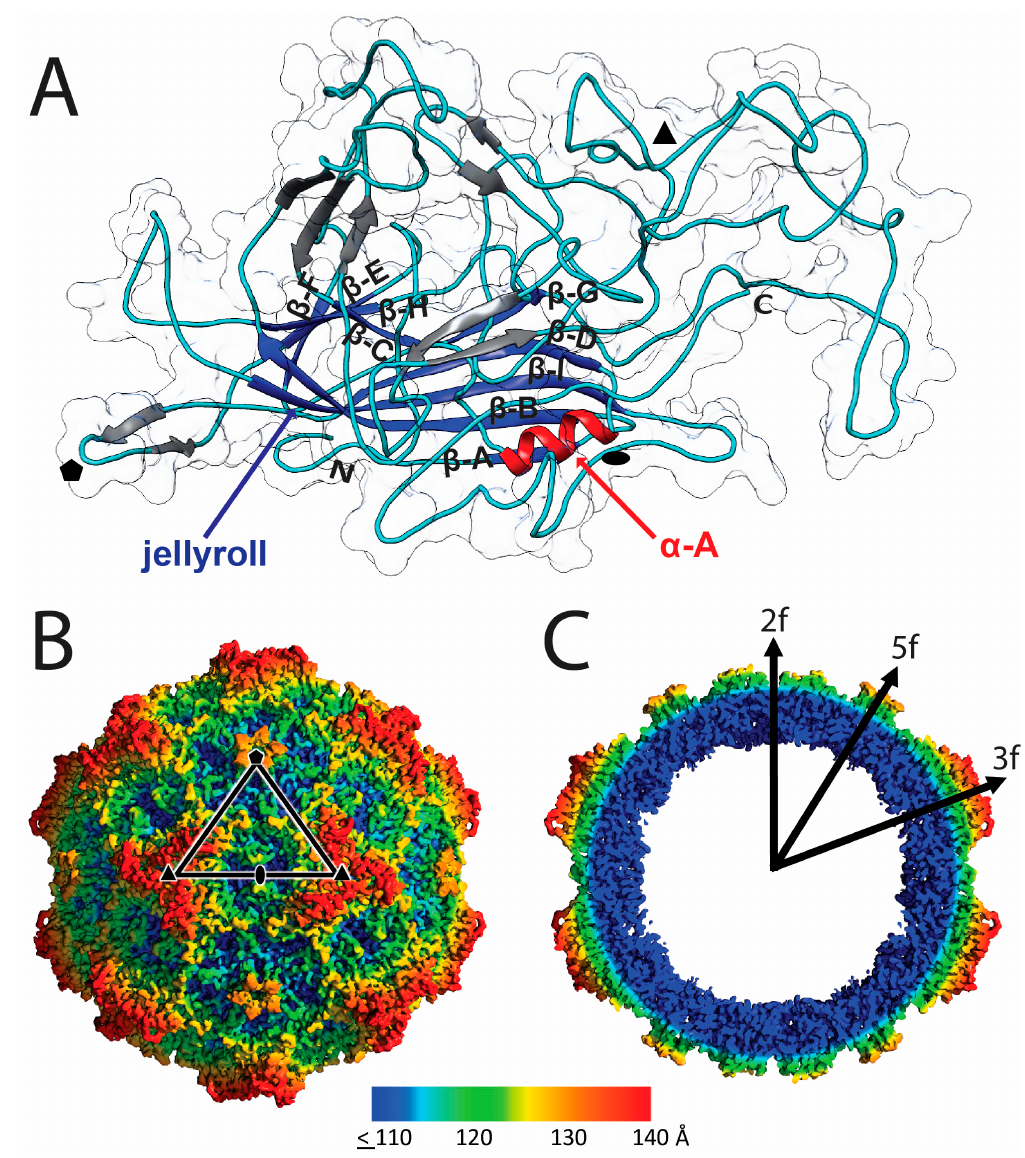
Figure 3. LuIII structure. ( A ) A VP2 monomer, 60 copies of which form the viral capsid. A cartoon is shown overlaid on a transparent surface representation. The jellyroll motif (blue), α -A helix (red), intervening loops (cyan), and short β -strands (gray) are shown. Arrows indicate anti-parallel β -strands with directionality from N- to C-terminus. N = N-terminus (VP2 37) and C = C-terminus (VP2 587). The approximate 2-fold, 3-fold, and 5-fold icosahedral axes are indicated as a filled oval, triangle, and pentagon, respectively; ( B ) surface image of the LuIII cryo-reconstructed map (at σ = 1) radially colored from the capsid center (see color key for distance in Å). The viral asymmetric unit is depicted in the black triangle with white outline. The icosahedral axes are indicated as in ( A ); ( C ) radially colored central section of the cryo-reconstructed map (at σ = 1). The color key is as in ( B ).